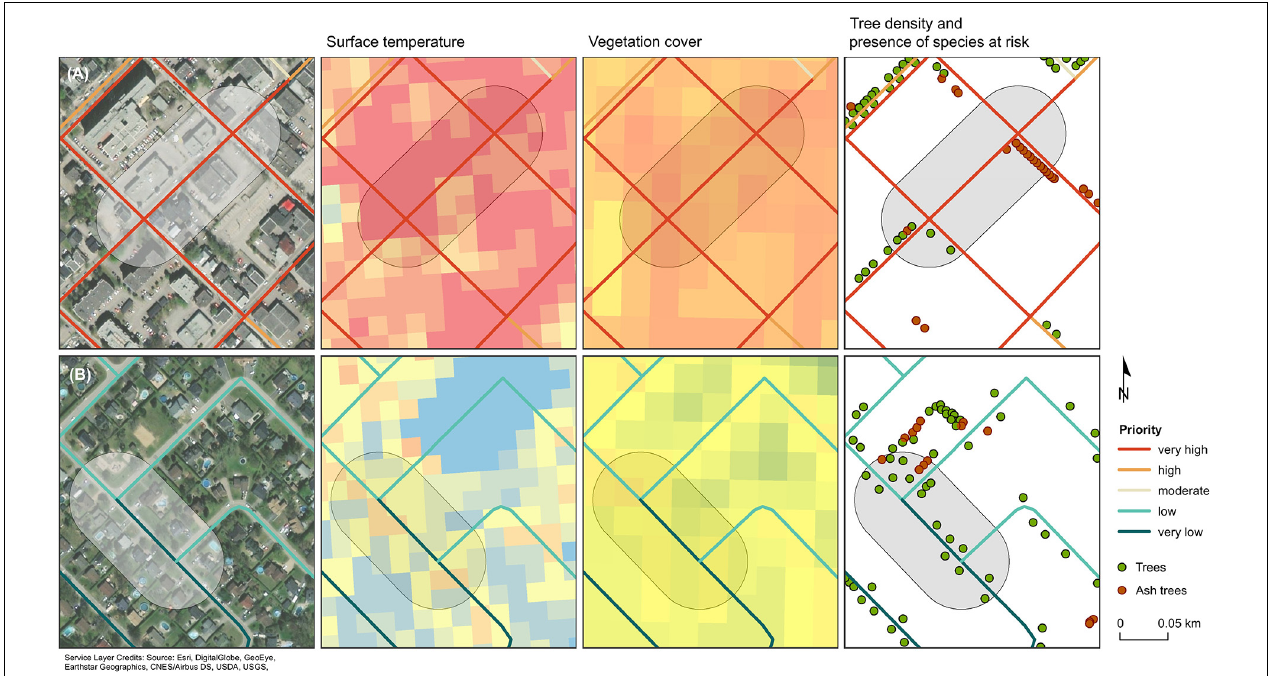
FIGURE 4 | Example of street segments with very high priority (A) and very low priority (B) for tree planting (weighted composite score assigned according to the “heat reduction scenario”; first column on the left). Buffer area (light gray) used to aggregate spatial data around each street segment is also shown. All spatial analyses were done using the Spatial Analyst tool in ArcGIS (version 10.7.1; www.arcgis.com). The examples shown here illustrate four indicators: surface temperature, vegetation cover, tree density, and presence of species at risk (here, ash trees). Street segments shown in red have a higher priority for